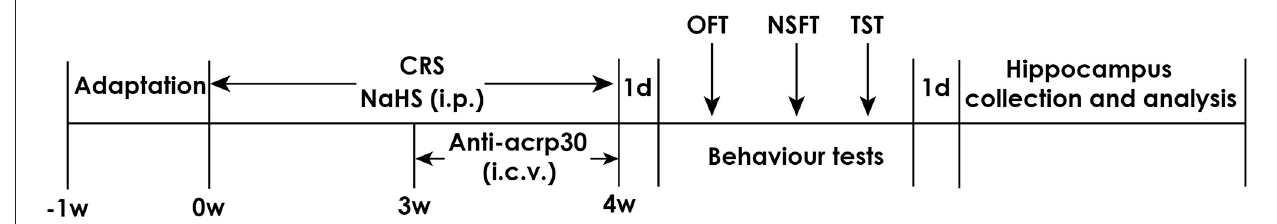
FIGURE 1 | Schematic diagram of the experimental procedures. CRS, chronic restraint stress; TST, tail suspension test; NSFT, novelty suppressed feeding test; OFT, open field test; i.p., intraperitoneal injection; i.c.v., intracerebroventricular injection.